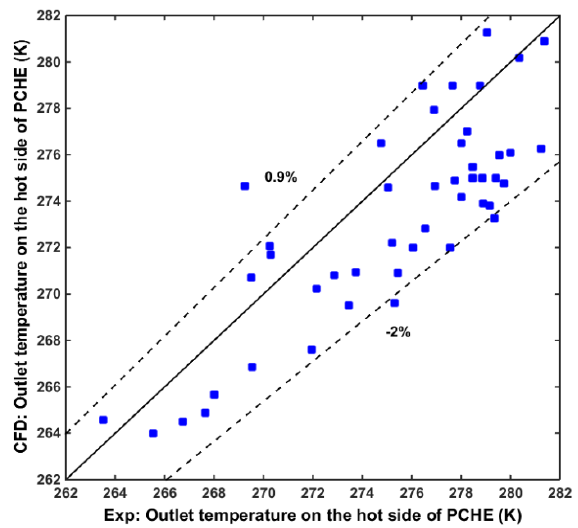
Figure 10. Deviations between the numerical and experimental outlet temperatures.